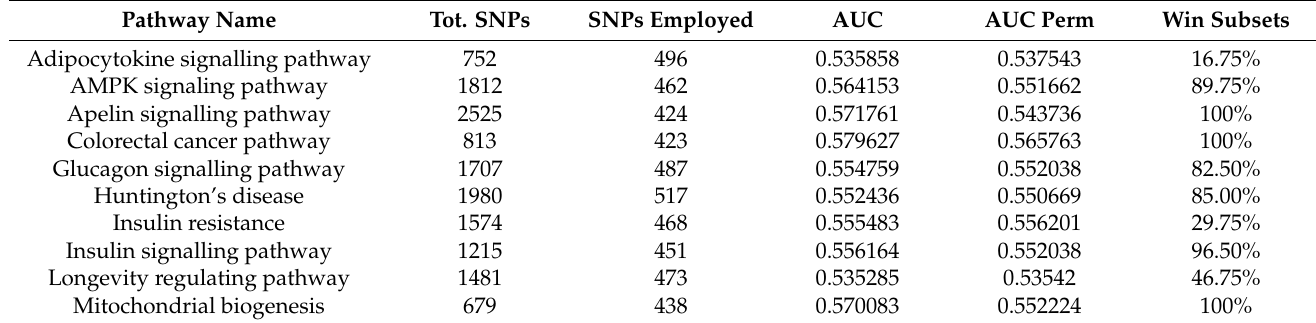
Table 3. Pathways under analysis. Total number of single nucleotide polymorphism (SNPs) per pathway (Tot. SNPs), SNPs employed in the 80 iterations by the non-permutated phenotypes (SNPs employed), average area under the receiver operation curve (AUC) obtained in the 80 iterations by the non-permutated phenotypes (AUC), AUC obtained by the permutated phenotypes (AUC perm.), percentage of non-permutated AUC values than are higher than the maximum permutated AUC value (win subsets).